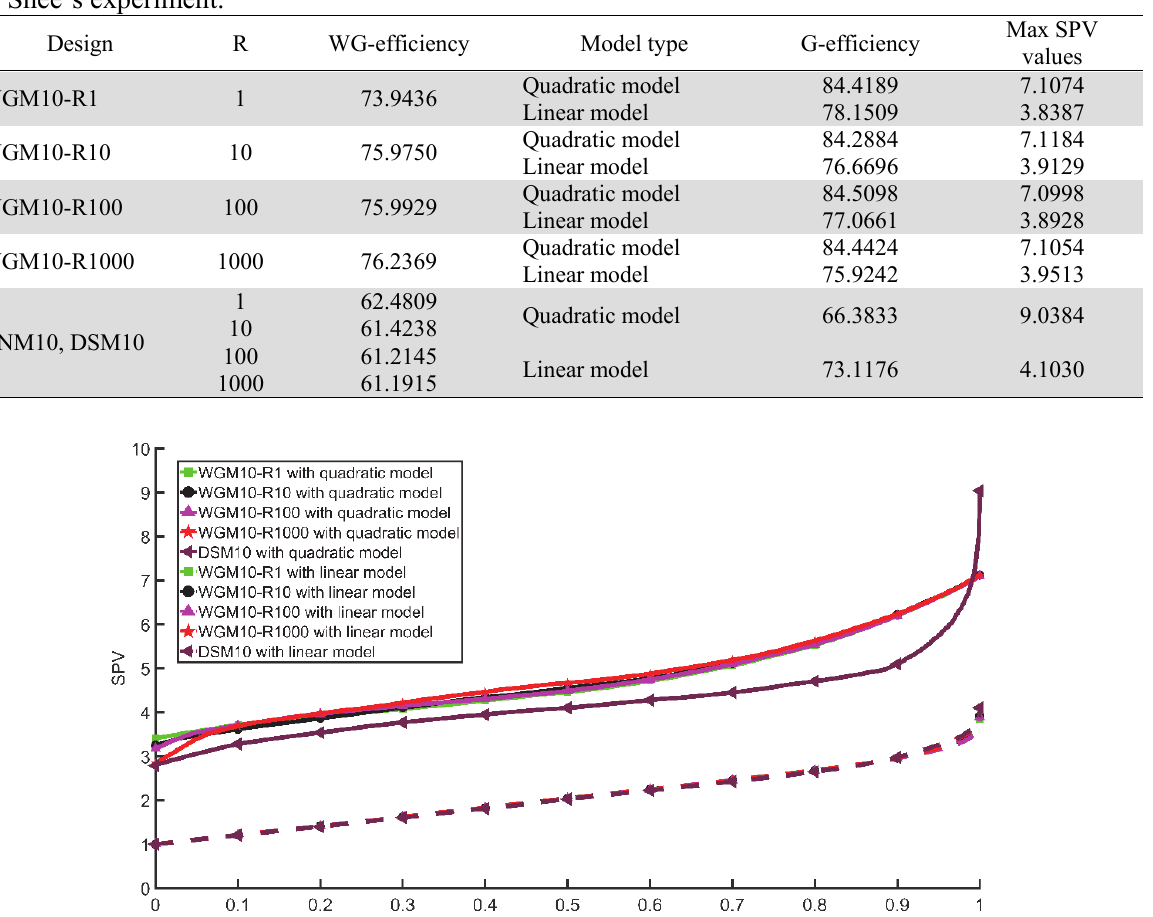
Fig. 4. FDS plot for comparing the WGM10 designs and the EA design for the Scheffé quadratic and linear models for Snee’s